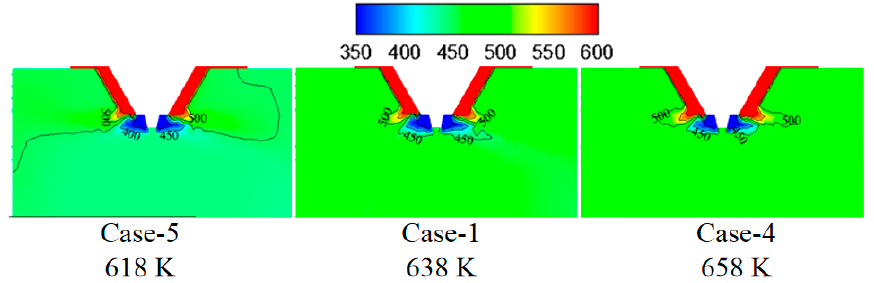
Figure 8. Temperature under different flue gas temperatures (K).